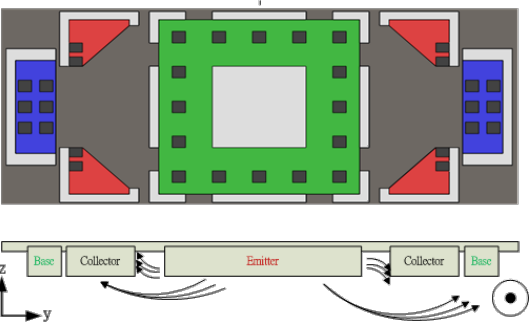
Figure 3. Current of magneto-transistor deflected by x-axis magnetic